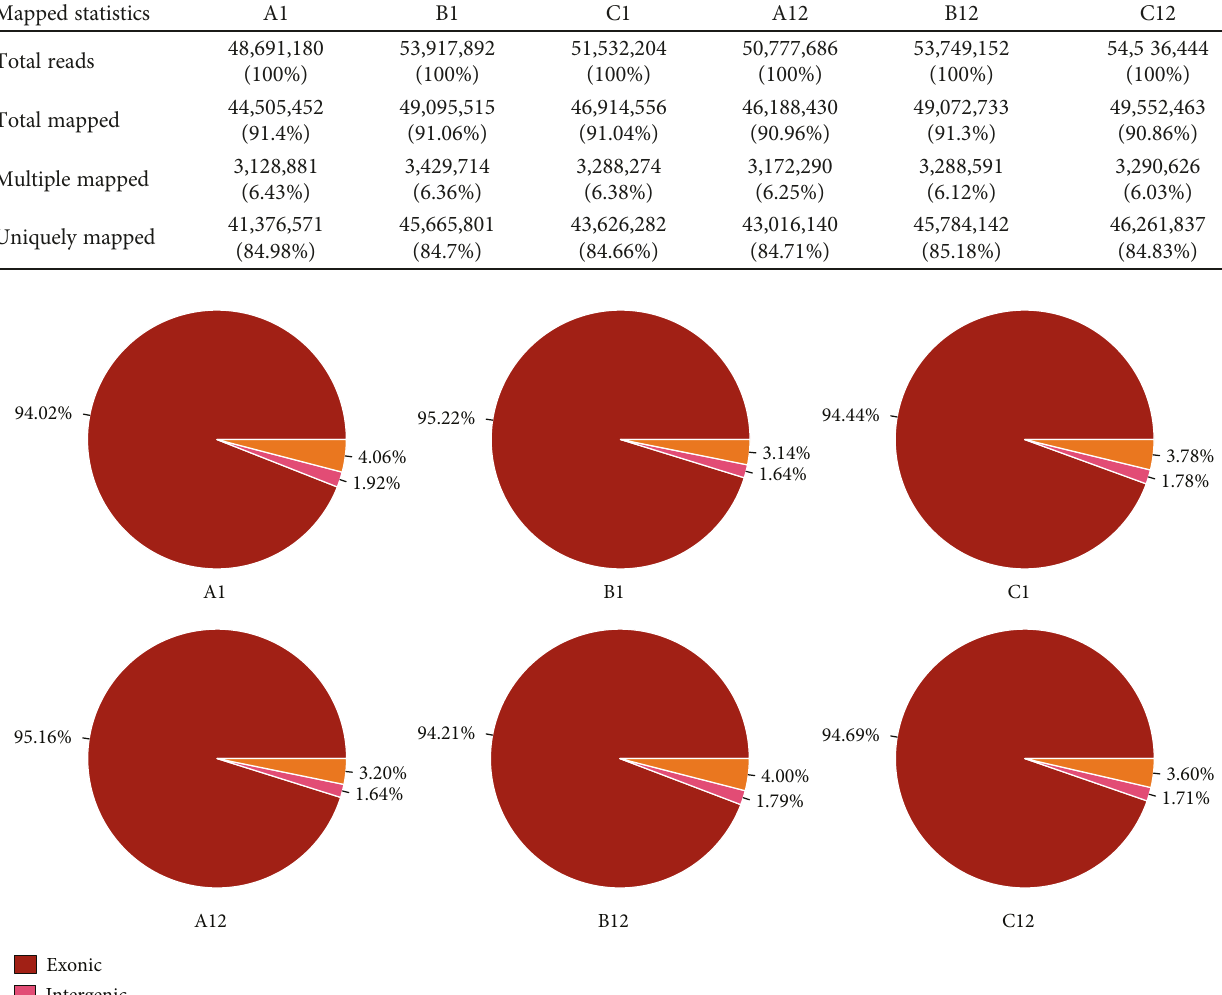
Table 1: Comparisons between clean data and Rattus genome sequences.